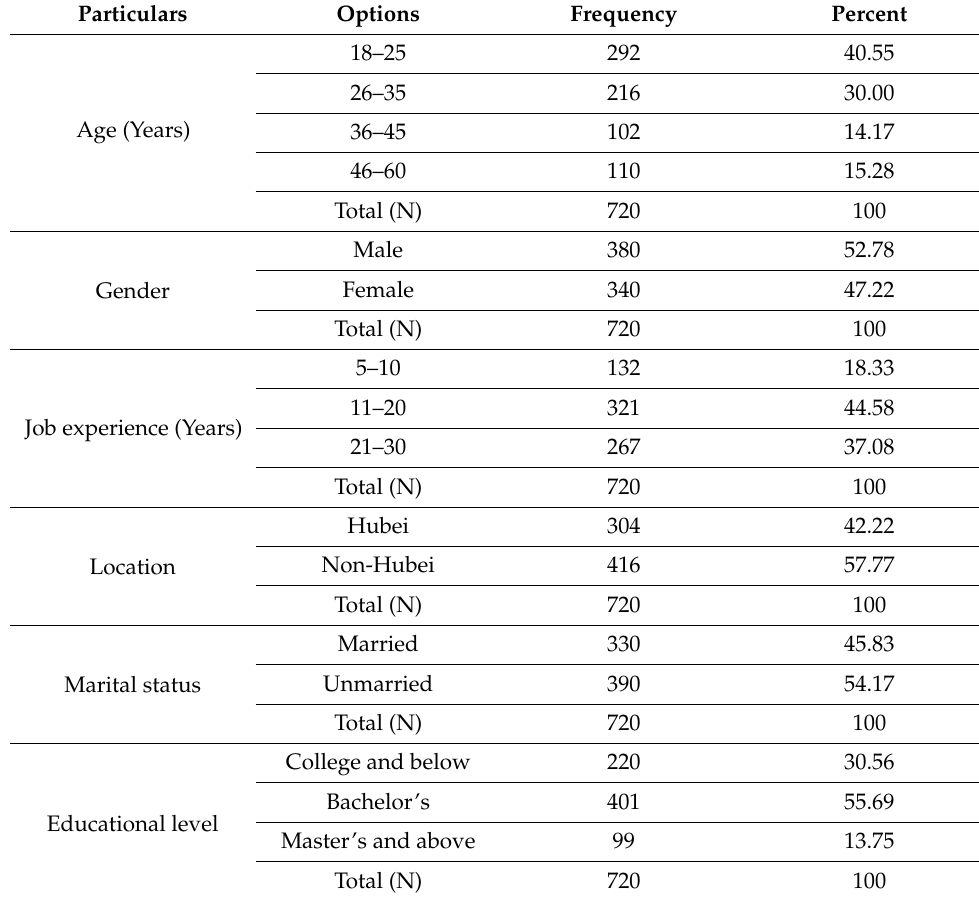
Table 1. The demographic information of the